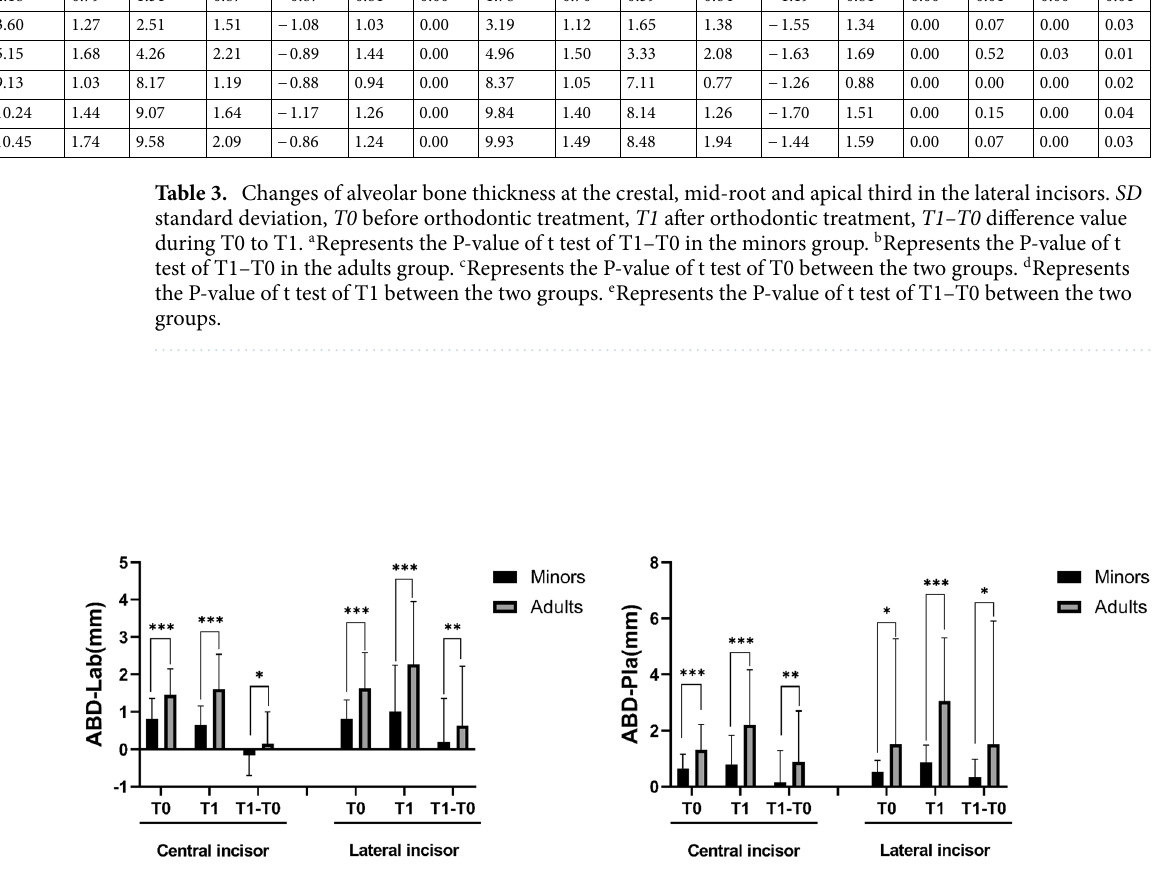
Figure 2. Changes in the labial and palatal alveolar bone distance in the central and lateral incisors before (T0) and after treatment (T1). *, P < 0.05; **: P < 0.01, ***, P <